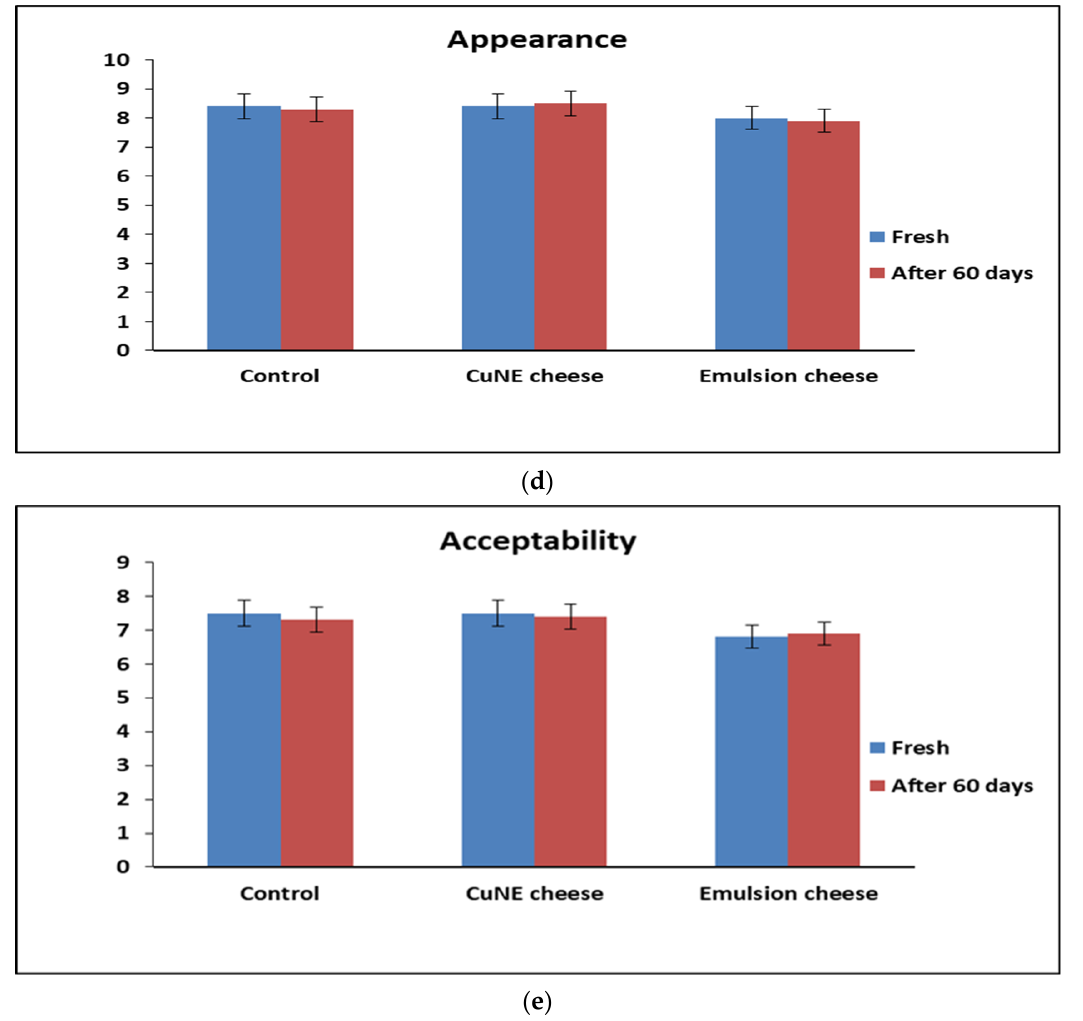
Figure 6. Sensory analysis of cheese sample with addition of curcumin nanoemulsion and emulsion: ( a ) Odor, ( b ) Taste, ( c ) Shade, ( d ) Appearance, and ( e ) Acceptability.